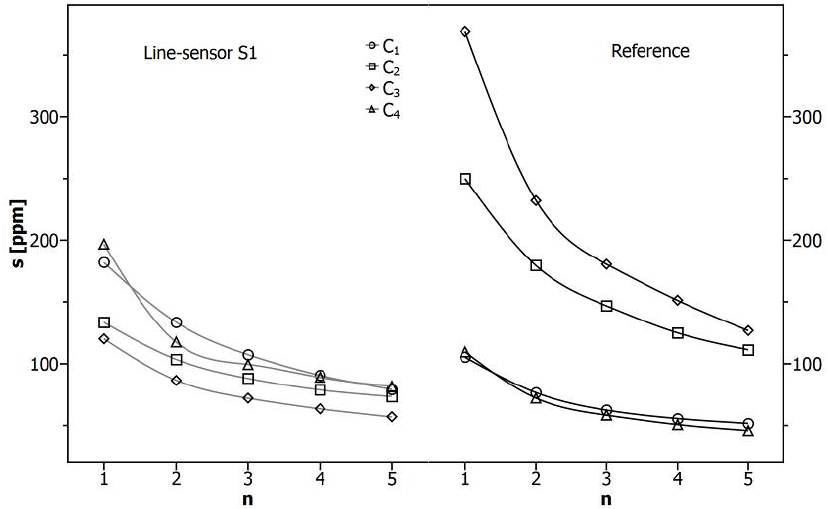
S1 ( left ) shows a lower standard deviation with respect to the reference ( right